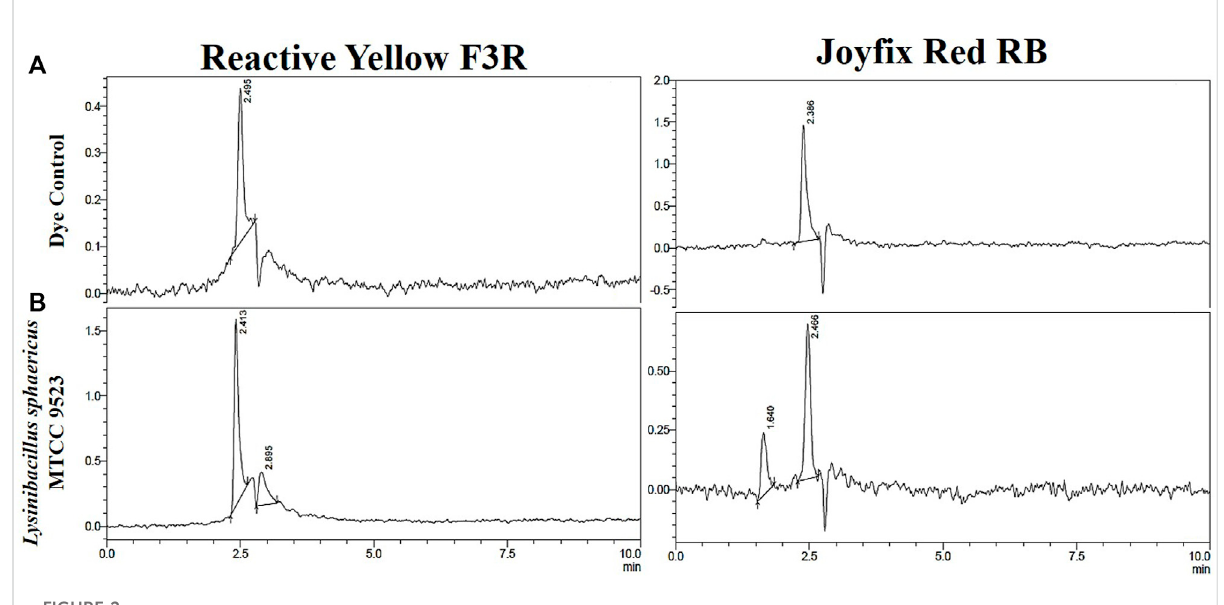
FIGURE 2 HPLC pro fi le of (A) Reactive Yellow F3R, Joy fi x Red RB dyes and (B) degradation products by L. sphaericus MTCC